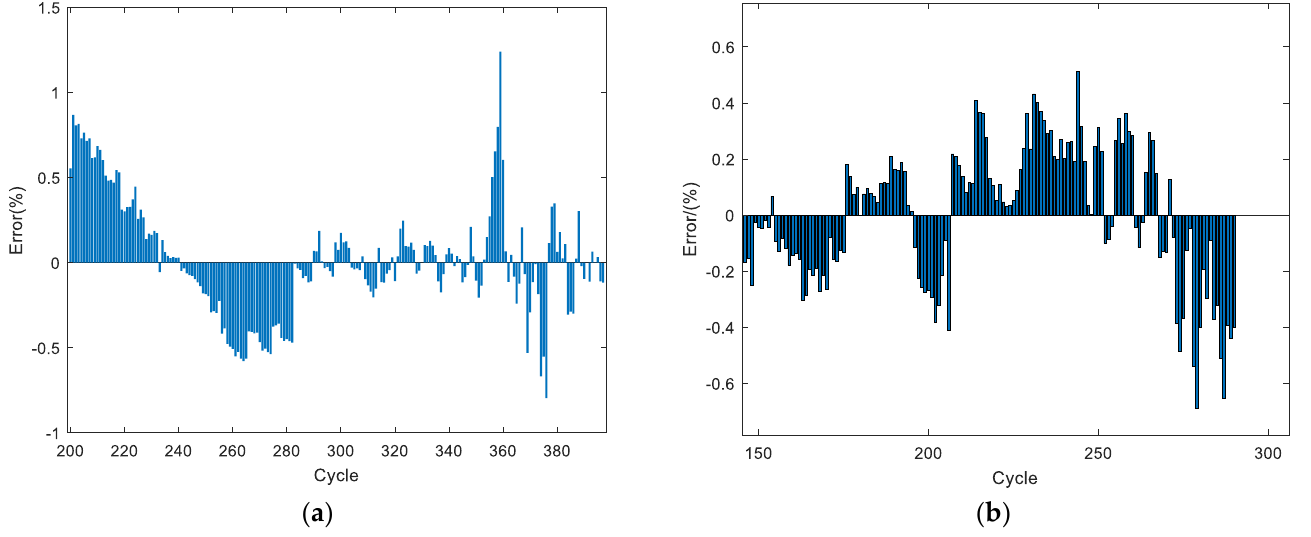
Figure 8. The SOH bar errors between estimation and measurement. ( a ) Battery pack; ( b ) battery cell.